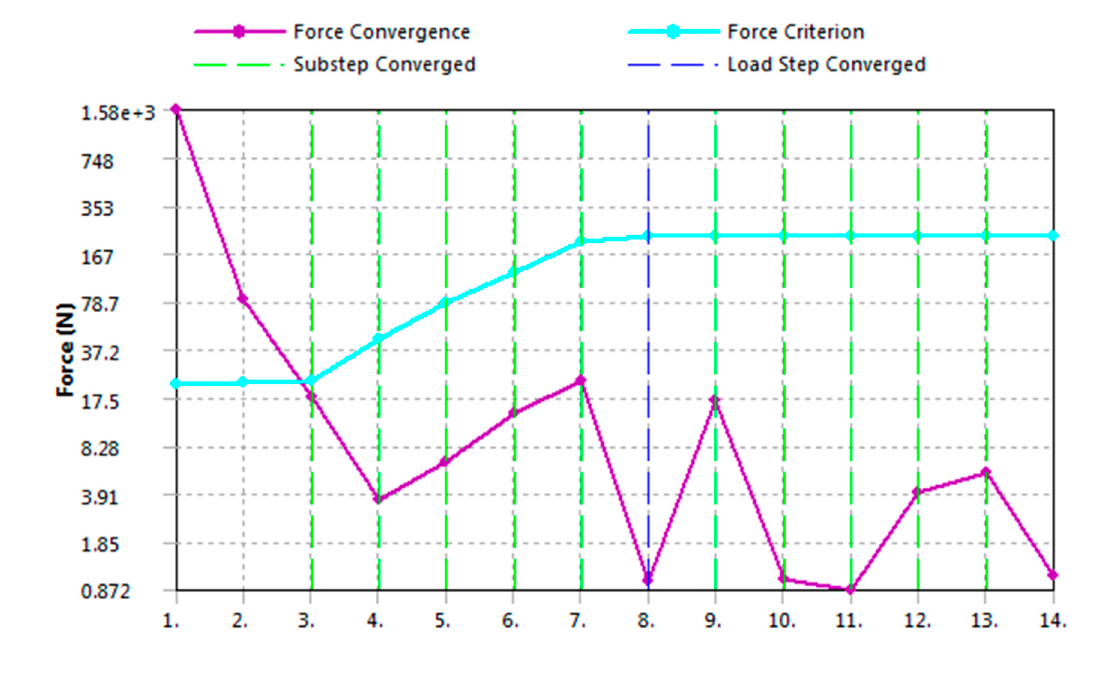
Figure 5. The phases of the structural behavior of a preloaded bolted joint.